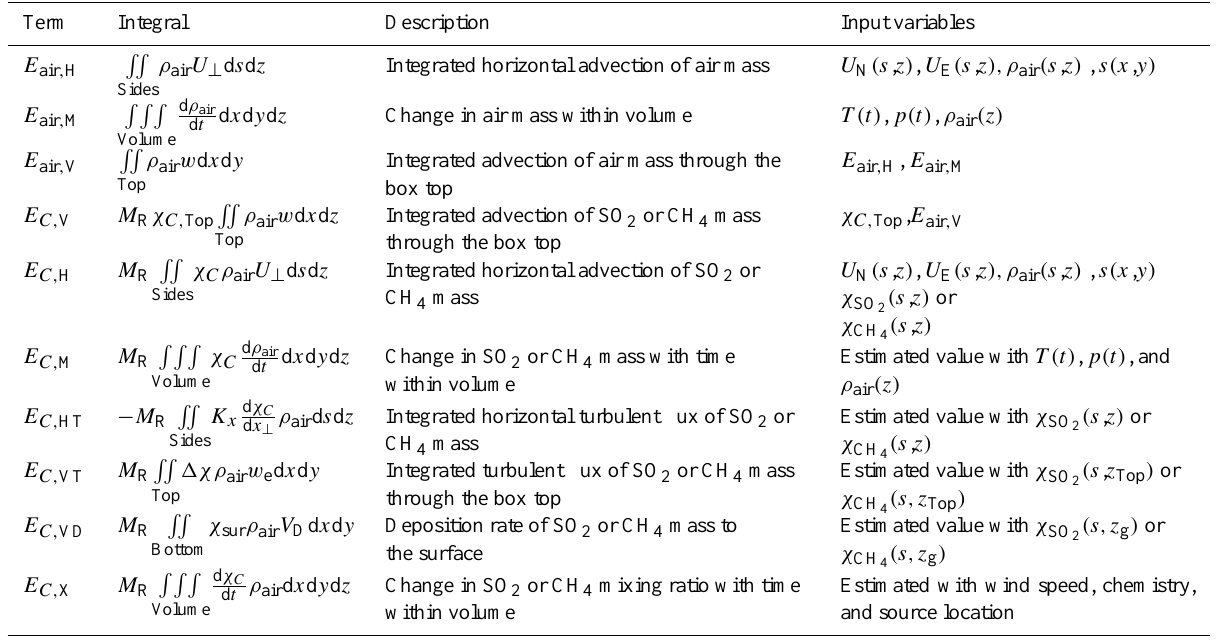
Figure 2. The mapping of aircraft position during the box flight to the box walls for the 20 August flight, showing (a) the complete flight path, (b) the box flight aircraft position data (black dots) and least-squares fit (red line), and (c) the unwrapped screen in the horizontal path length ( s) and height ( z) dimensions. The ground elevation ( z g (s)) beneath the flight path fit is shown in grey shading (c) . Table 2. Terms from Eqs. (1) and (2) used to solve for the total emission rate, E C . The necessary input variables are listed with their functional dependence. See text for explanation of